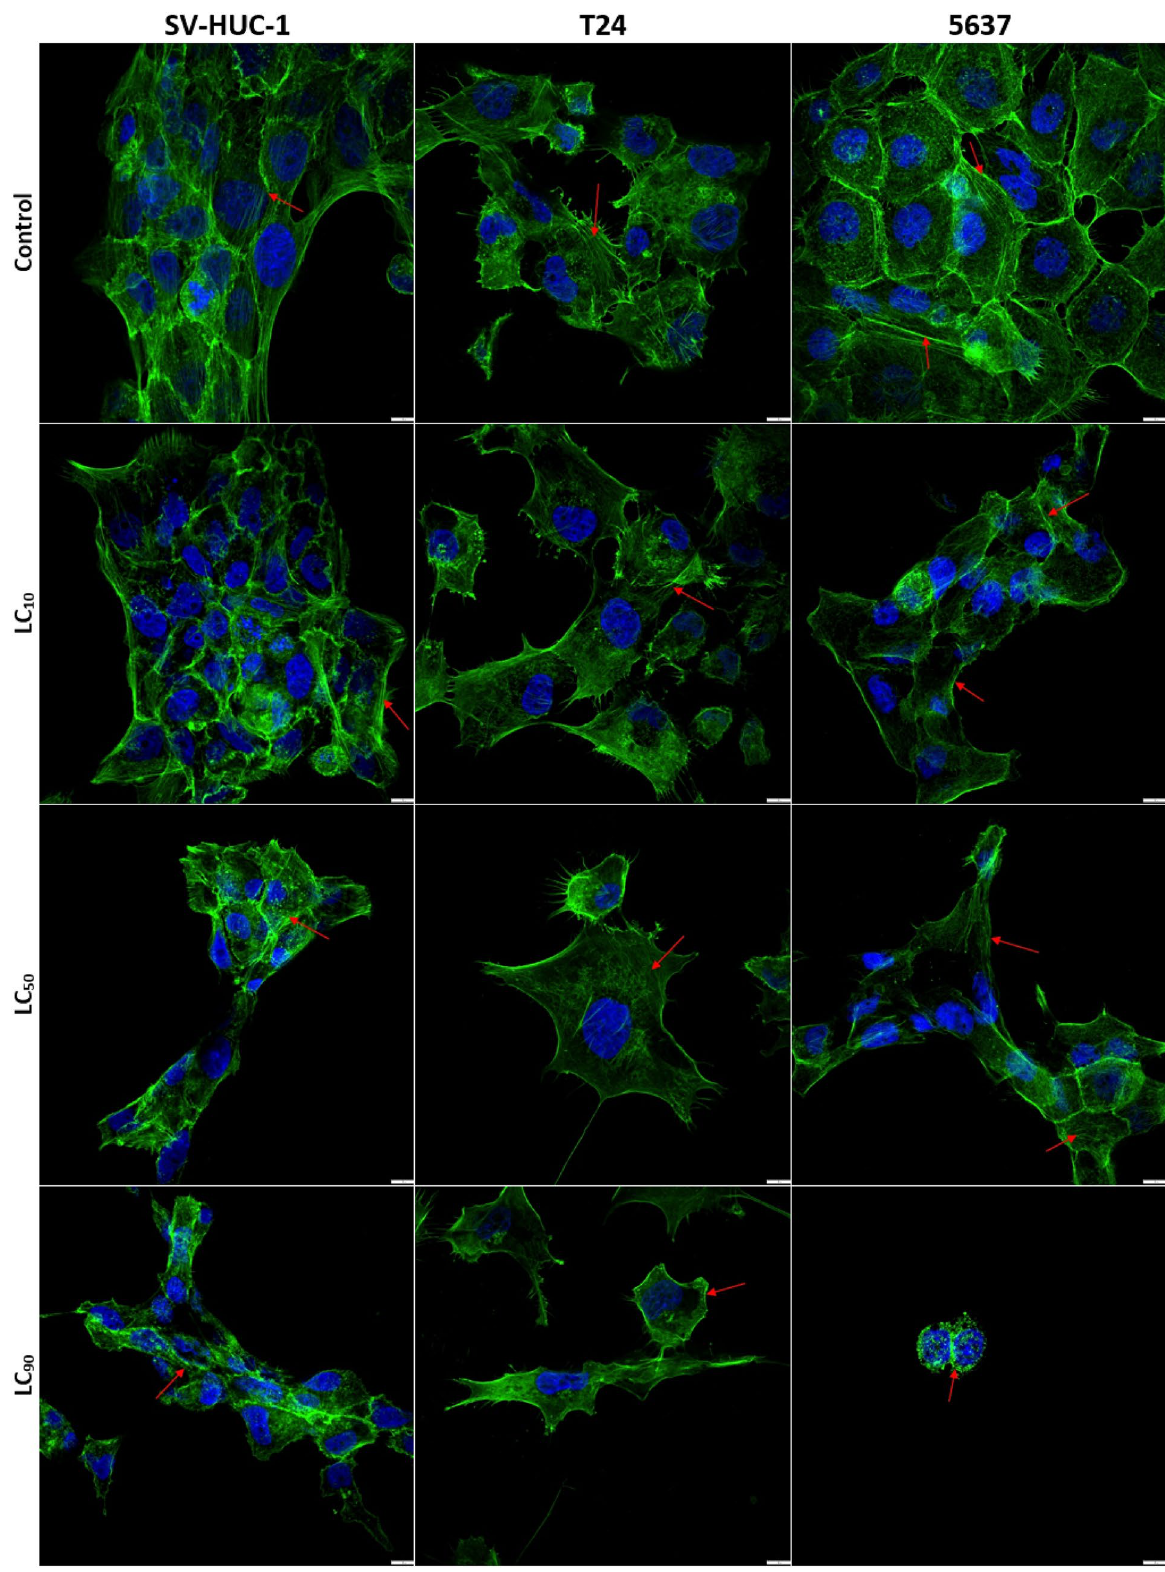
Figure 7. SV-HUC1, T24 and 5637 cells stained with Alexa Fluor 488 phalloidin (green) and DAPI (blue) after exposure to the corresponding 24 h lethal concentrations of Mumio. Degradation of stress fibres was noticed after exposure to Mumio in all tested cell lines. Fluorescent microscopy (100×, bar 10 μm). SV-HUC-1—normal urothelial cell line, T24—transitional urinary bladder carcinoma cell line, 5637—grade II urinary bladder carcinoma cell line, LC—lethal